Question: Author a descriptive caption for the visualization shown.
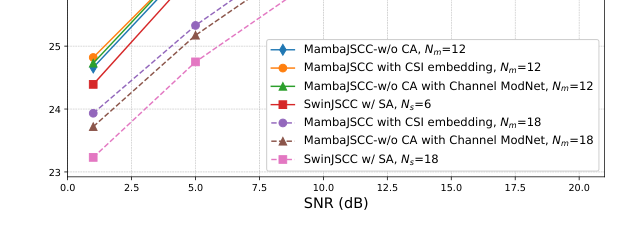
Answer: illustrates the performance of SwinJSCC w/ SA and MambaJSCC with different channel adaptation methods versus SNR under the AWGN and the Rayleigh fading channel. The Nm is set to 12 for the AWGN channel and 18 for the Rayleigh fading channel. Ns is set to 6. We can see that MambaJSCC with CSI embedding significantly outperforms SwinJSCC w/ SA across all SNRs in the both channels. For example, in the AWGN channel, a maximum gain of 0.43 dB is achieved at SNR=1 dB, and the minimum gain is 0.19 dB at SNR=20 dB. For the Rayleigh fading channel, the performance improvements at different SNRs are consistent, with an average gain of 0.65 dB. Moreover, the parameter size and the computational complexity of MambaJSCC with CSI embedding are significantly lower than those of SwinJSCC w/ SA. As shown in Table II, compared to SwinJSCC w/ SA with Ns = 6, MambaJSCC with CSI embedding requires 12.32 billion fewer MACs, 11.70 million fewer parameters for Nm = 12, and 7.39 billion fewer MACs and 6